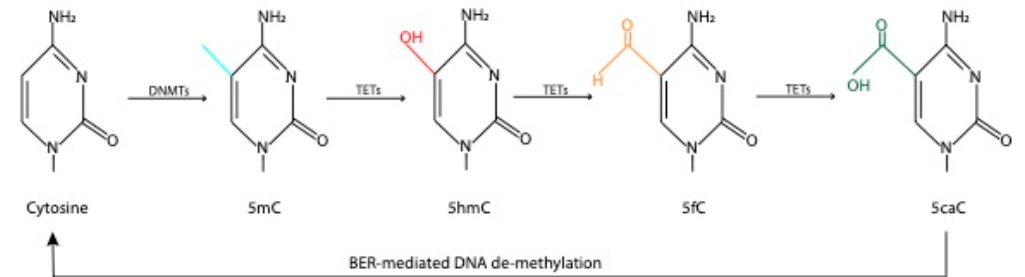
Figure 1. Schematic representation of methylation and de-methylation. Cytosines in the 5 ′ position are methylated by DNA methyltransferases (DNMTs) to produce 5mC. Ten-eleven translocation (TET) enzymes mediate several oxidation steps to produce 5hmC, 5fC and 5caC, which can undergo base excision repair (BER), in which modified cytosine is replaced by an unmethylated cytosine, resulting in active de-methylation.